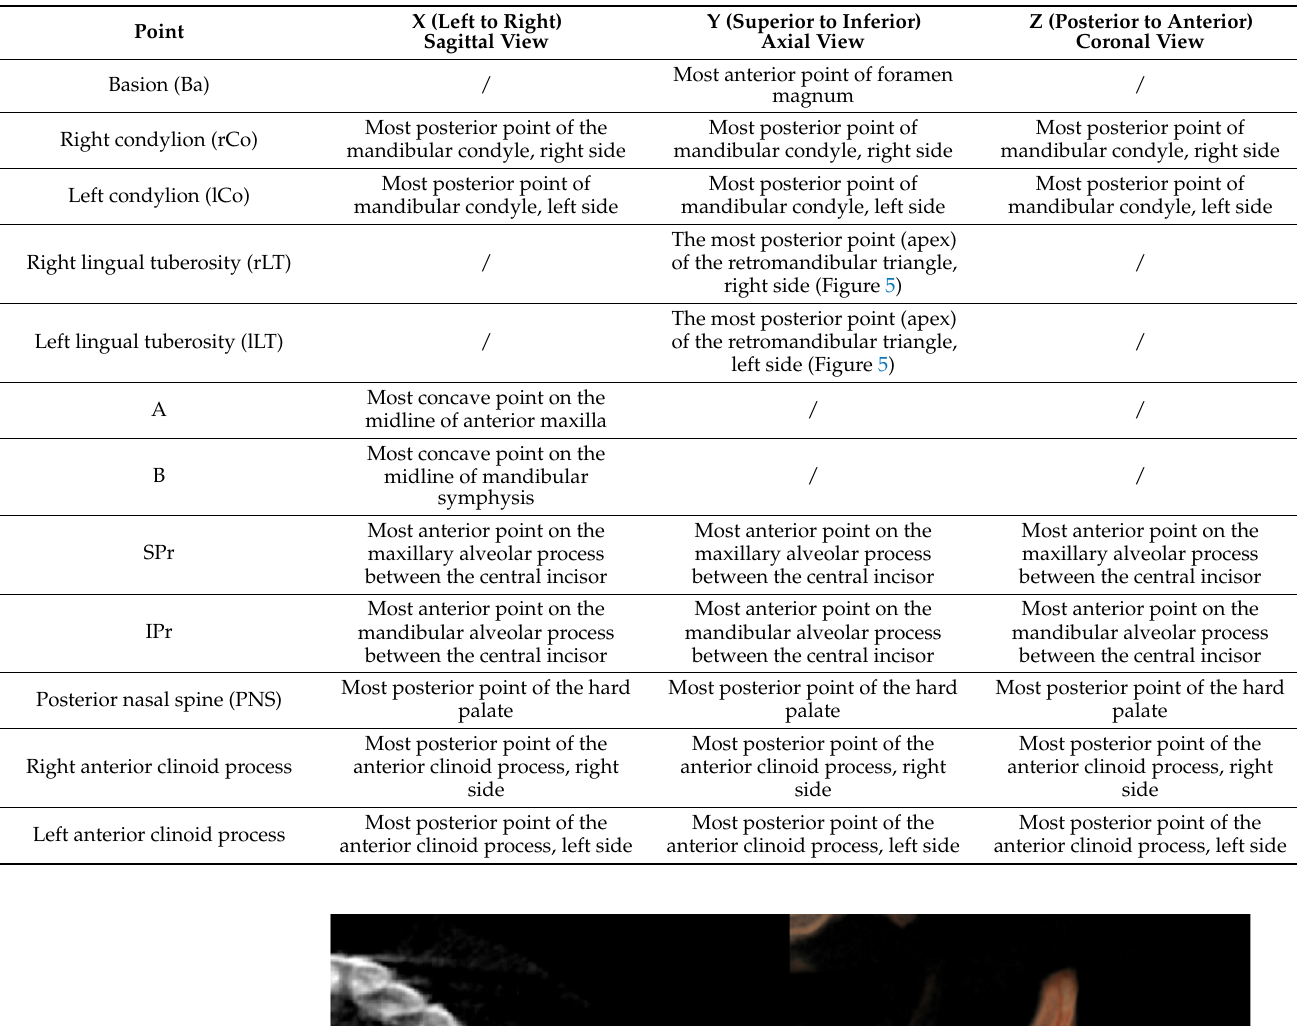
Table 2. Landmarks identified in the 3D analysis.